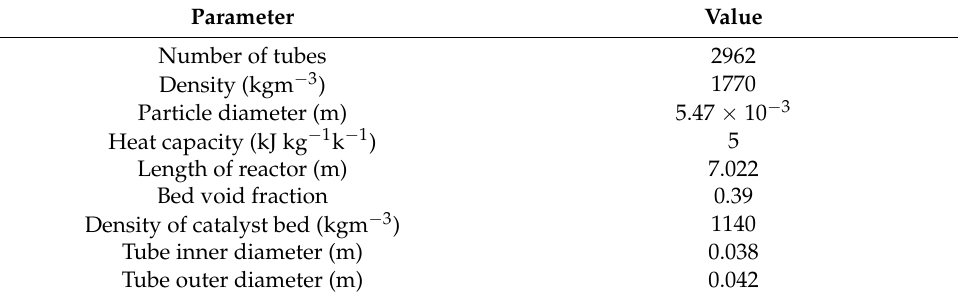
Table 5. Catalyst and reactor data